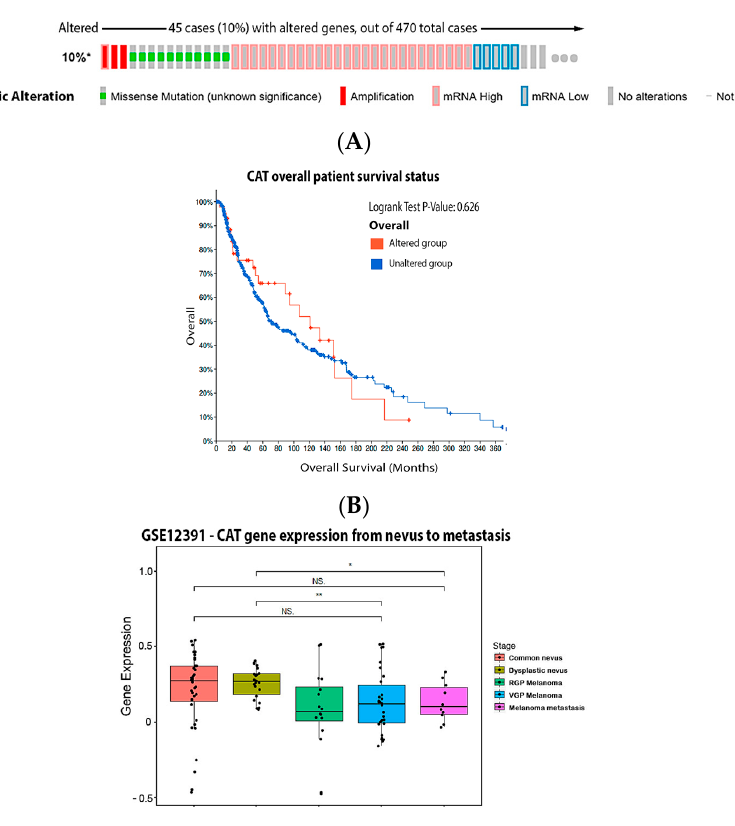
Figure 4. Catalase on melanoma. ( A ) Percentage of patients with altered genes and types of genetic alterations; ( B ) overall patient survival status, and ( C ) expression in melanoma progression. Red boxes represent the common nevus, yellow boxes the dysplastic nevus, green boxes the radial growth phase (RGP) melanoma, blue boxes the vertical growth phase (VGP) melanoma, and purple boxes the metastatic melanoma. The statistical analysis was performed by ANOVA followed by Tukey test, ** p < 0.01, * p < 0.05 when compared to common or dysplastic nevus. NS: Not